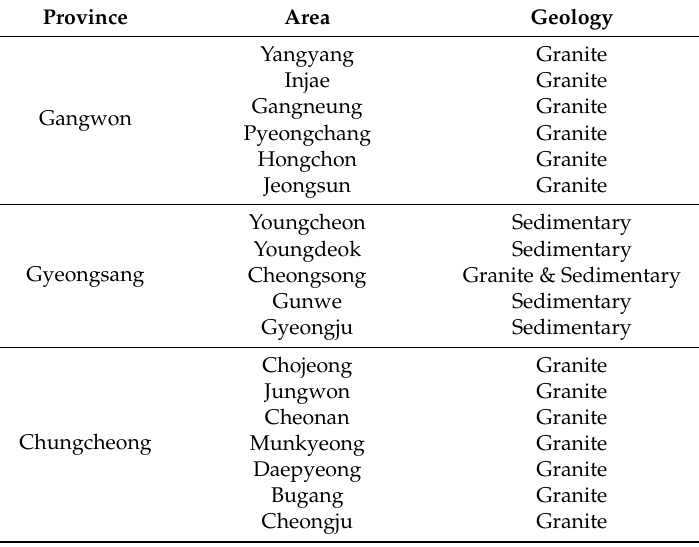
Table 2. The location of CO 2 -rich water in Korea (Kim et al., 2002).